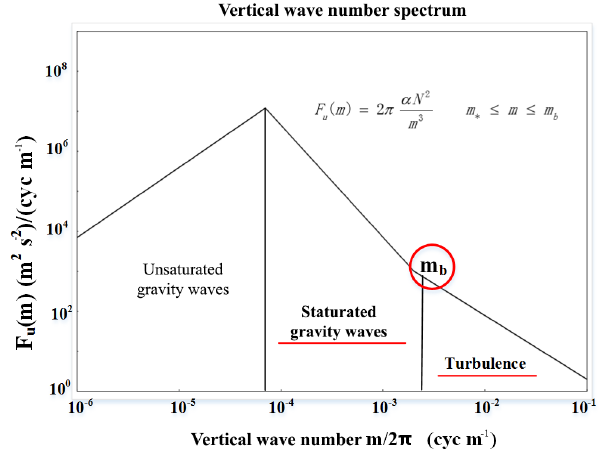
Figure 3. The canonical gravity wave vertical wave number spec- trum of horizontal wind fluctuations. From J. Atmos. Terr. Phys., 58, 1577,